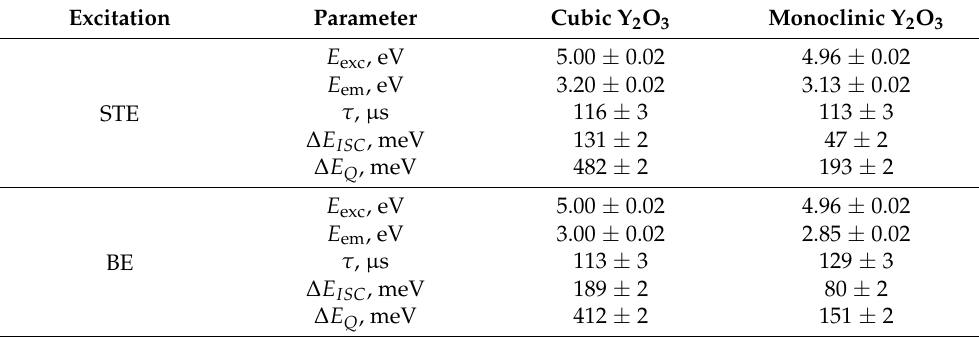
Table 2. Spectral-kinetic parameters of elementary excitations in cubic and monoclinic nanocrystalline Y 2 O 3 films. E exc and E em are the maxima of excitation and emission bands, which are associated with self-trapped exciton ( STE ) and bound exciton ( BE ); τ is the lifetime of an excited state; ∆ E ISC and ∆ E Q are the thermal activation barriers of intersystem crossing and emission quenching, respectively. Parameters of the monoclinic Y 2 O 3 film were taken from Ref.